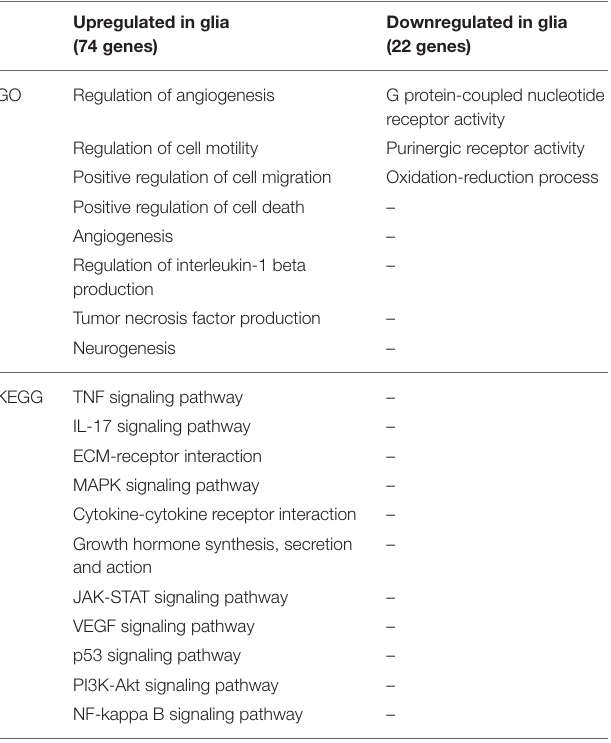
Downregulated in neurons (16 genes)